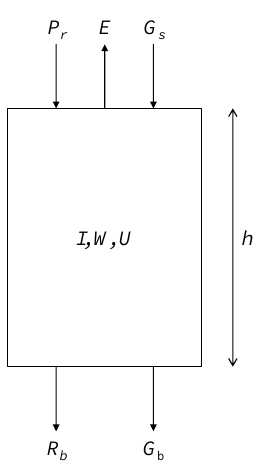
Figure 1. System diagram for a snow column of height h with ice mass I , liquid water mass W and internal energy U . Arrows show mass and energy fluxes at the top and bottom of the